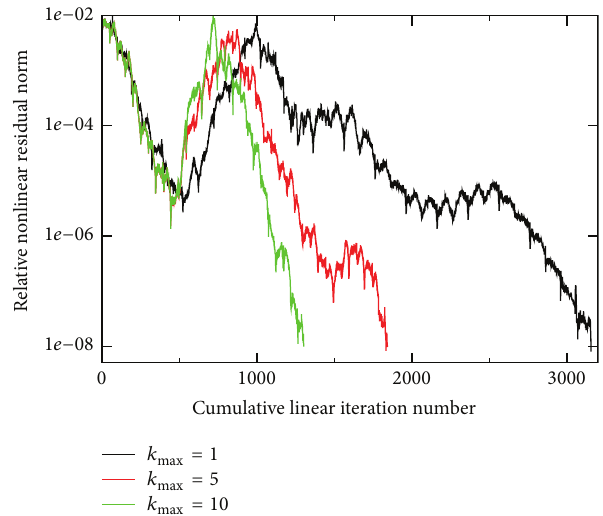
Figure 1: Convergence profile of the relative residual norm ver- sus cumulative inner iterations for eigenvalue number 3, matrix FLOW3D-663